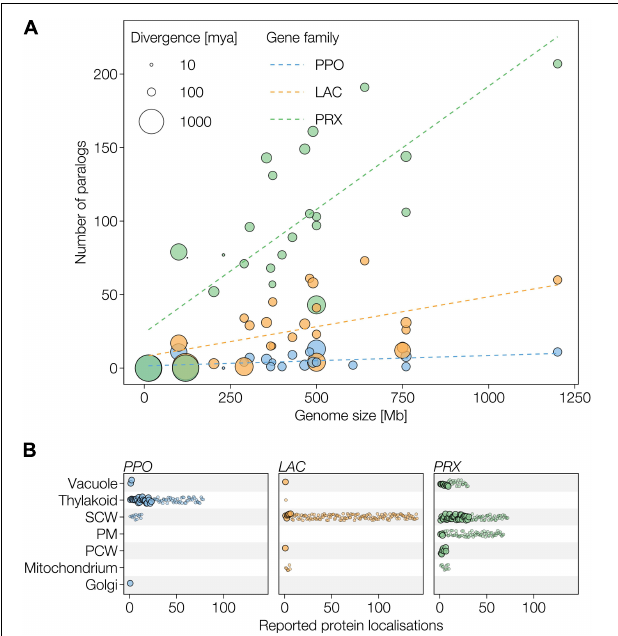
FIGURE 3 | Differences in evolutionary duplication and sub-cellular localisation of the different type of plant phenoloxidases. (A) Evolution of plant phenoloxidase multigenic families. Number of genes encoding for PPOs, LACs, and class III PRXs are plotted against the genome size of the respective species. Circle size indicates evolutionary divergence from A. thaliana in million years ago. Fitted lines represent the trends of multigenic family sizes against total genome size. (B) Predicted and experimentally confirmed subcellular localisations of PPO, LAC, and class III PRX paralogs in plants. Large dots represent experimentally verified localisations, small dots are predictions. PCW, primary cell wall; PM, plasma membrane; SCW, secondary cell wall. All paralogs predicted to the apoplast are placed at SCW.